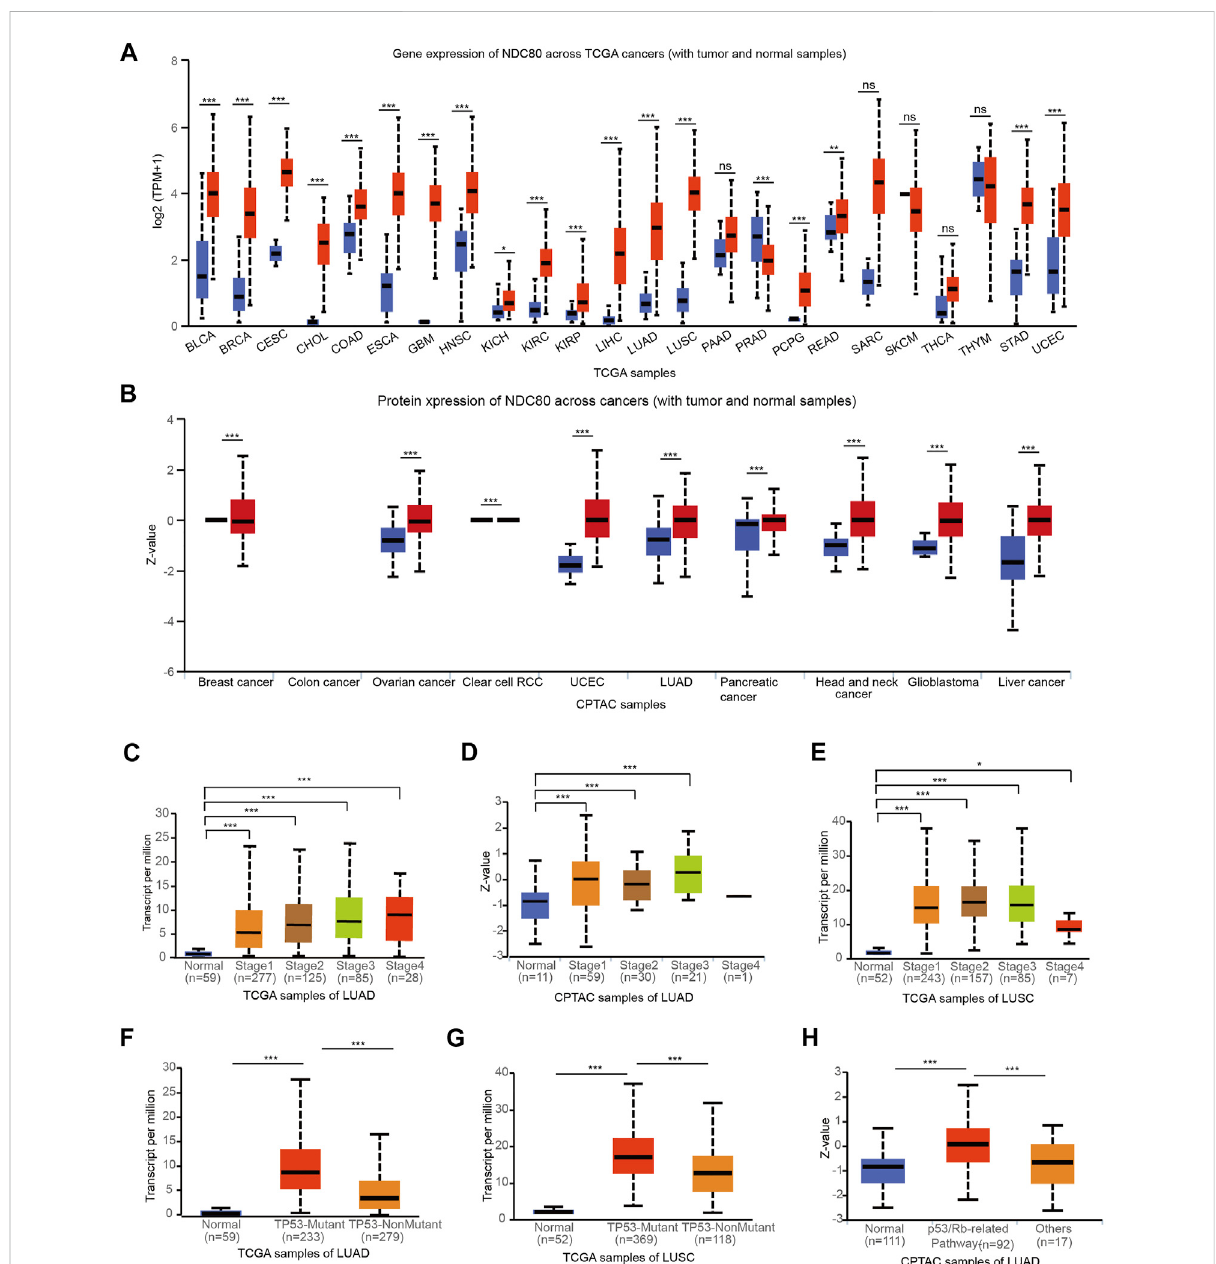
FIGURE 2 Validation of the expression level and clinical signi fi cance of NDC80. (A,B) A pan-cancer analysis for the comparison of the transcriptional and protein expression of NDC80 between cancerous and healthy control tissues through the TCGA (A) and CPTAC databases (B) from UALCAN platforms. (C – E) The correlation of the NDC80 expression level with stages of LUAD using the TCGA (C) and CPTAC (D) databases, and in the LUSC (E) dataset. (F – H) The association of NDC80 expression level with p53 mutations in the LUAD (F) and LUSC (G) datasets, and with the p53/Rb pathway in the LUAD (H) dataset. * p < 0.05; *** p <